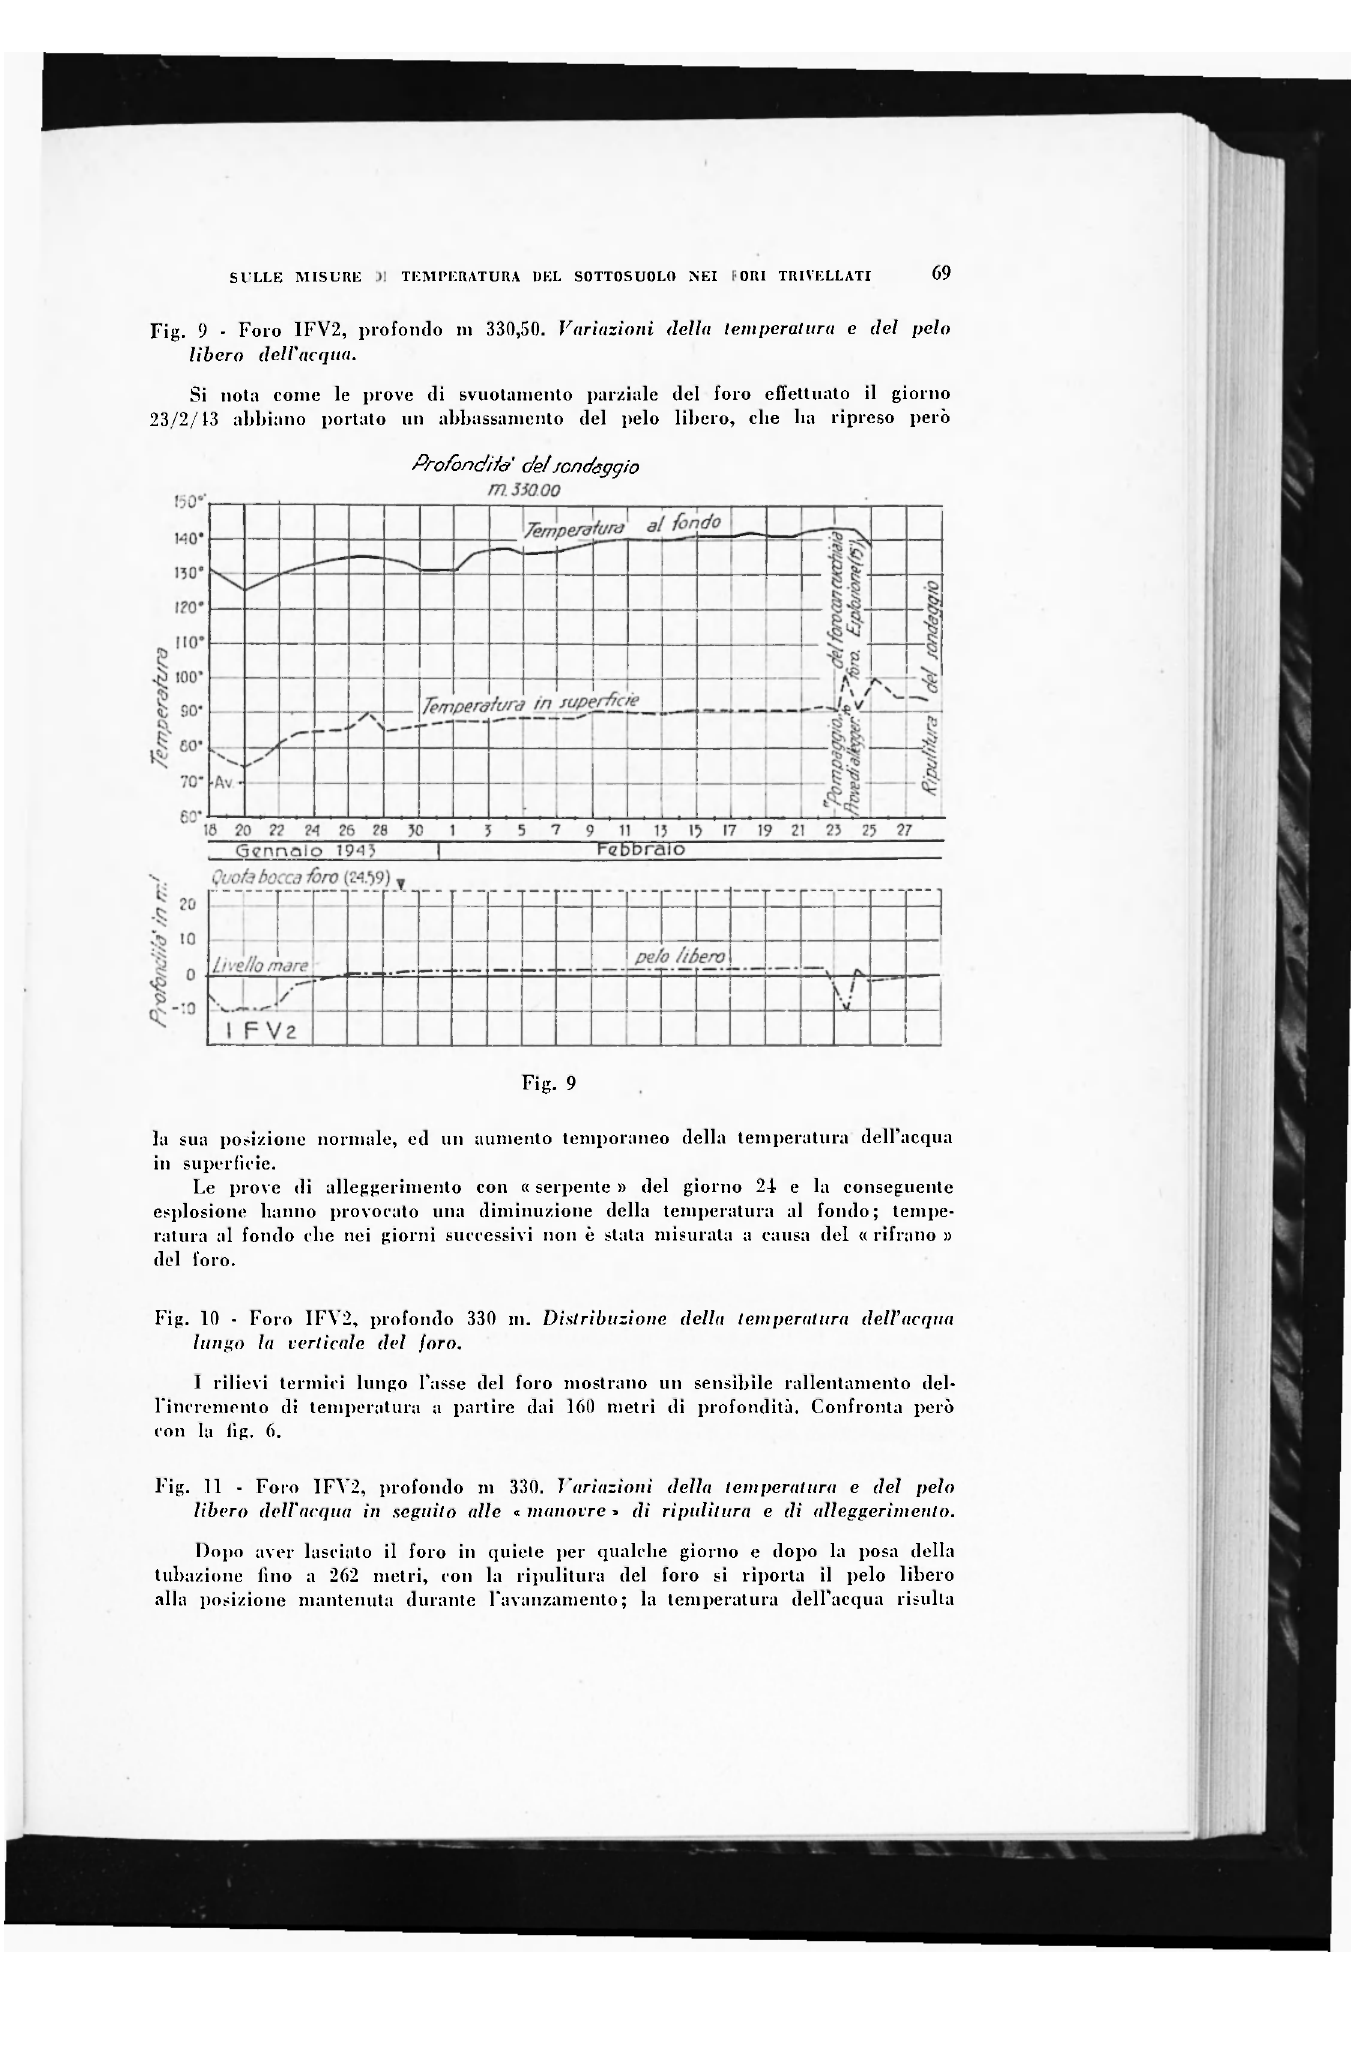
Fig. 9 - Foro 1FV2, profondo m 330,50. Variazioni della temperatura